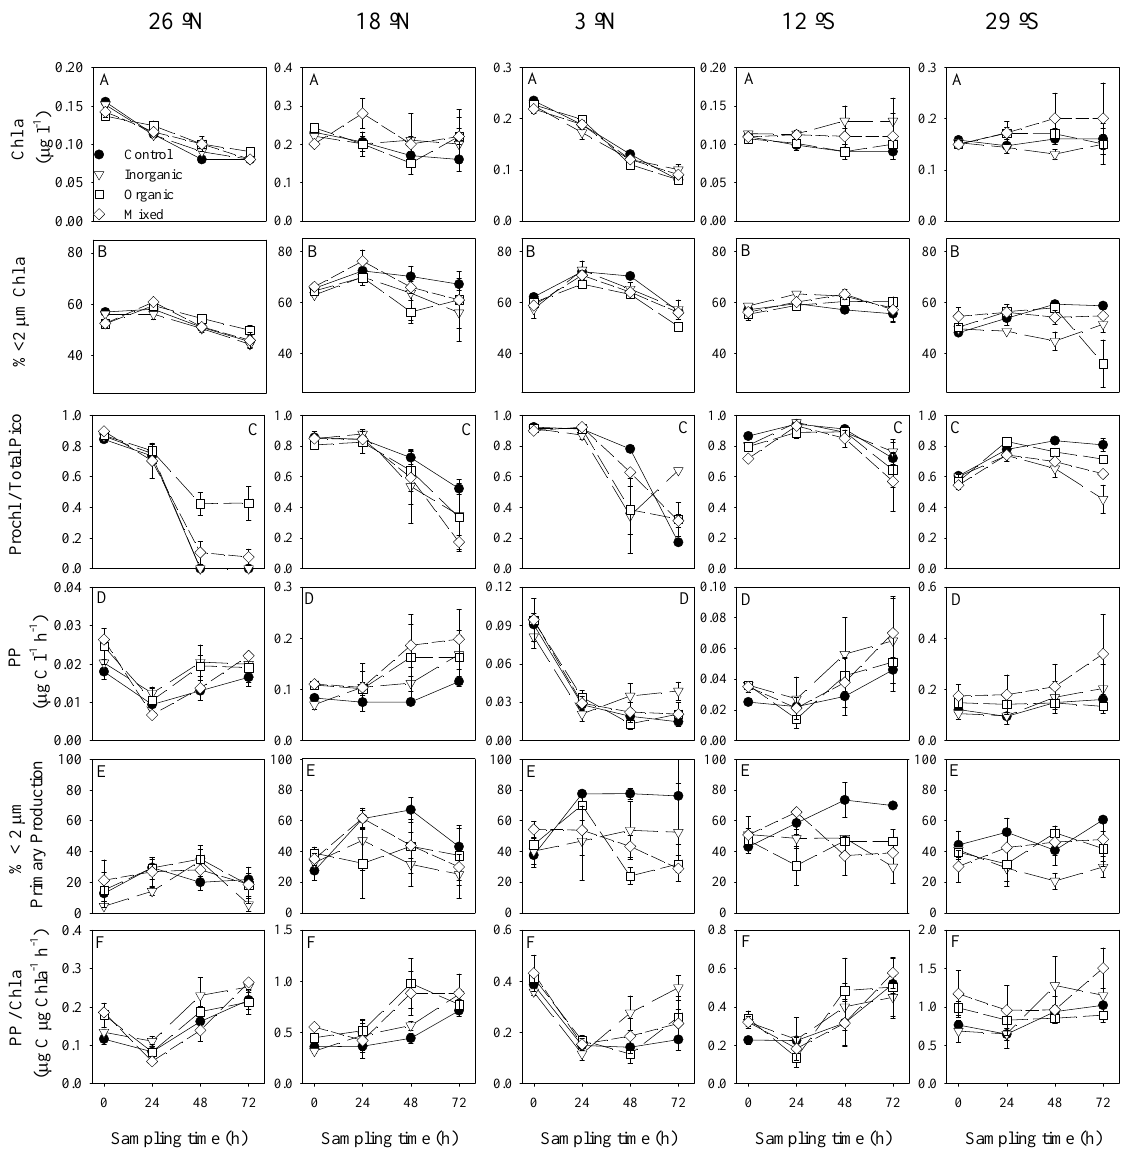
Fig. 3. Time course of the mean (A) , chl a , chlorophyll a (µgl − 1 ) ; (B) , % < 2µm chl a , percentage of < 2µm chlorophyll a ; (C) , Prochl: Total Pico., Prochlorococcus: Total picophytoplankton biomass ratio; (D) , PP, total primary production (µgCl − 1 h − 1 ) ; (E) , % < 2µm PP, percentage of < 2µm primary production; (F) , PP/chl a , primary production to chl a ratio, in the 5 experiments. Control, no addition; Inorganic, inorganic addition; Organic, organic addition; Mixed, mixed addition. Note that different scales were used. Error bars represent the standard error from two replicates; where error bars are not visible, they are smaller than the size of the symbol. of all these variables were registered after organic and